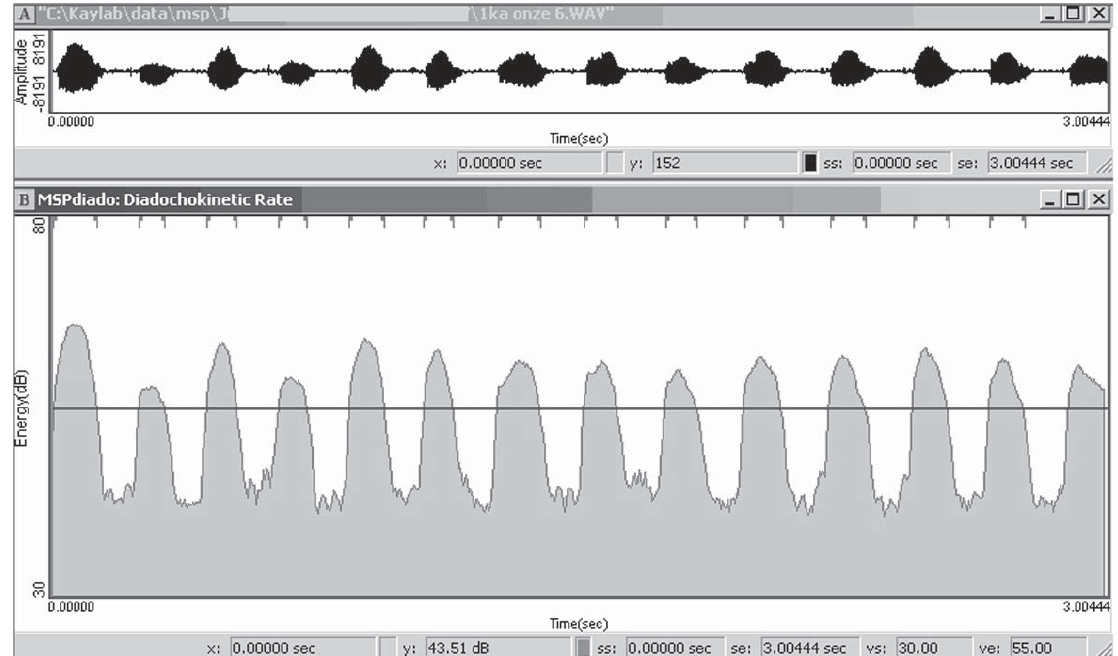
Figure 2- (cid:2)(cid:26)(cid:12)(cid:27)(cid:4)(cid:17)(cid:14)(cid:7)(cid:12)(cid:2)(cid:28)(cid:11)(cid:8)(cid:11)(cid:5)(cid:2)(cid:29)(cid:30)(cid:7)(cid:7)(cid:14)(cid:15)(cid:2)(cid:3)(cid:5)(cid:11)(cid:31)(cid:22)(cid:7)(cid:2)(cid:18)(cid:28)(cid:29)(cid:3)(cid:21)(cid:2)(cid:30)(cid:5)(cid:11)!(cid:5)(cid:4)(cid:6)(cid:2)!(cid:5)(cid:4)(cid:30)(cid:15)(cid:13)(cid:14)#(cid:2)$(cid:15)(cid:7)(cid:5)(cid:7)(cid:2)(cid:8)(cid:13)(cid:6)(cid:7)(cid:2)(cid:18)(cid:9)(cid:7)(cid:14)(cid:11)(cid:17)(cid:12)(cid:9)(cid:21)(cid:2)(cid:11)(cid:17)(cid:2)(cid:8)(cid:15)(cid:7)(cid:2)(cid:15)(cid:11)(cid:5)(cid:13)(cid:24)(cid:11)(cid:17)(cid:8)(cid:4)(cid:22)(cid:2)(cid:4)&(cid:13)(cid:9)(cid:2)(cid:4)(cid:17)(cid:12)(cid:2)(cid:7)(cid:17)(cid:7)(cid:5)!(cid:23)(cid:2) (dB) on the vertical axis can be